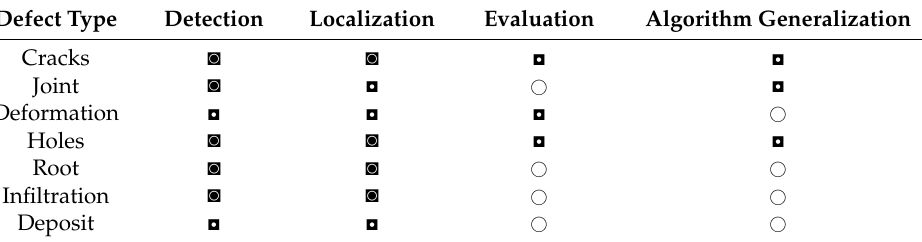
Table 3. Automation of sewer defects assessment.